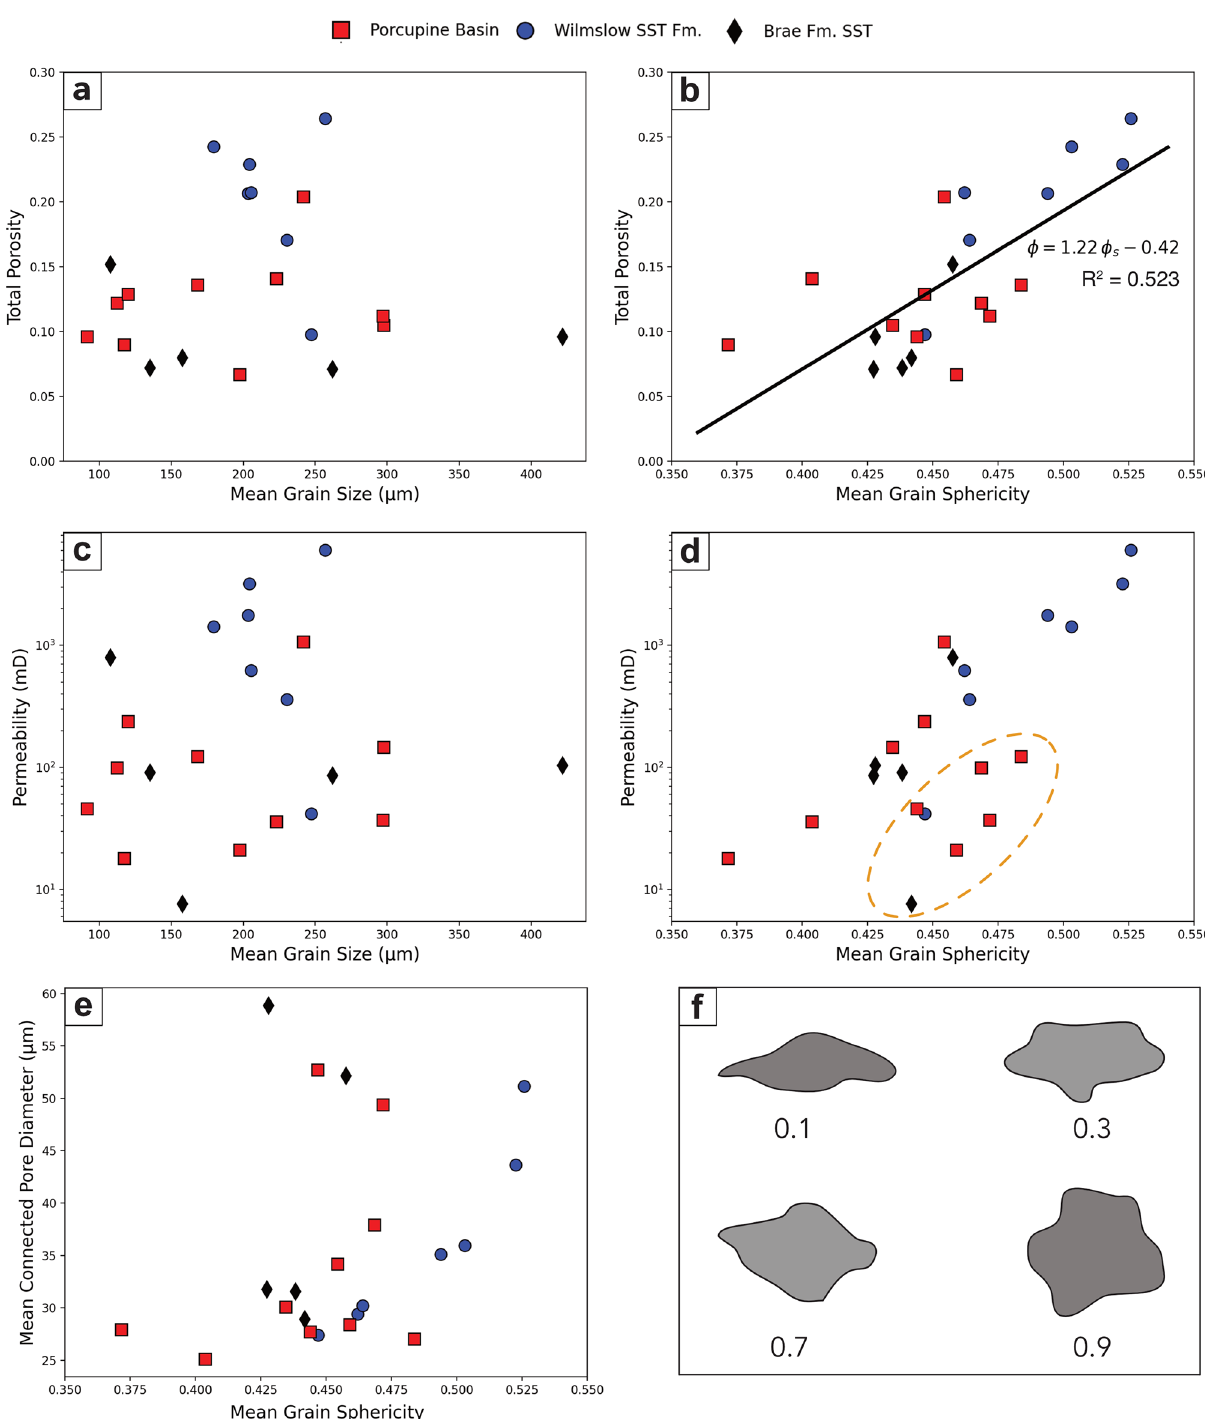
Figure 3. Relationship between mean grain size, mean grain sphericity and total porosity, permeability and mean connected pore diameter. Grain sphericity is measured on a scale between 0 and 1 where 1 is entirely spherical, a schematic diagram is shown to represent the range of sphericities according to Krumbein 46 plotted in ( f ). A generally positive relationship with porosity and permeability can be observed in the case of mean grain sphericity in ( b ) and ( d ), but no such relationship is present with mean grain size in ( a ) and ( c ). A region of outliers is identified by a dashed line in ( d ) with the same data points also apparent in ( b ) to a lesser extent. A simple linear fit is calculated between grain sphericity (φ s ) and porosity (φ), defined by the black line and accompanying equation in ( b ). It is apparent that there is a generally positive relationship between sphericity and connected pore diameter aside from a small group of four outliers ( e